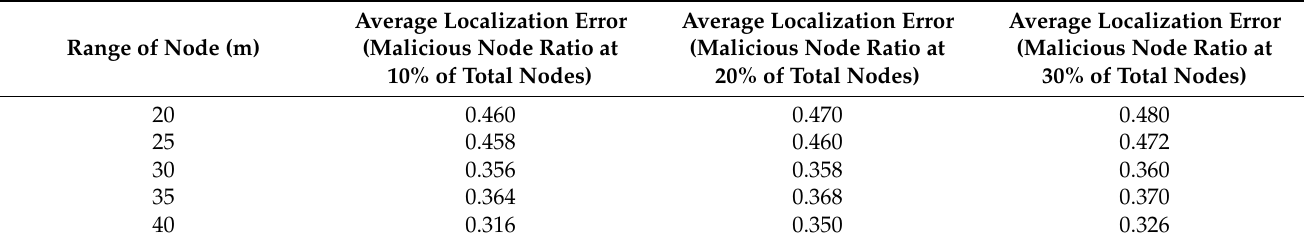
Range of Node (m)